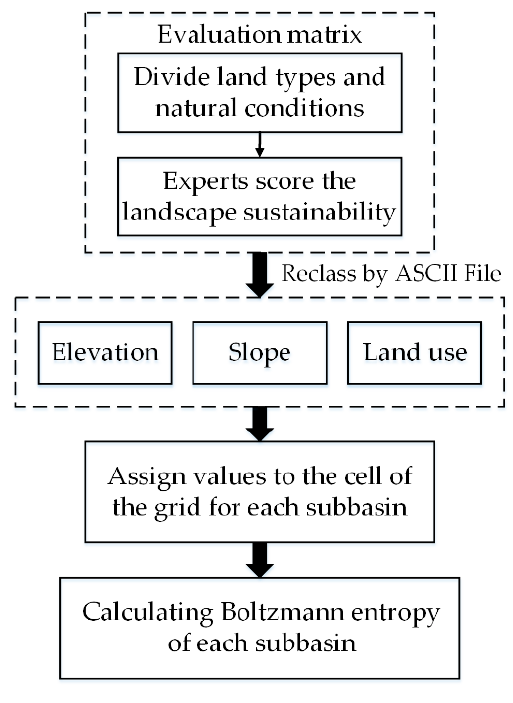
Figure 2. Method flow chart. Table 1. The evaluation matrix of landscape sustainability in Mizhi (1–10